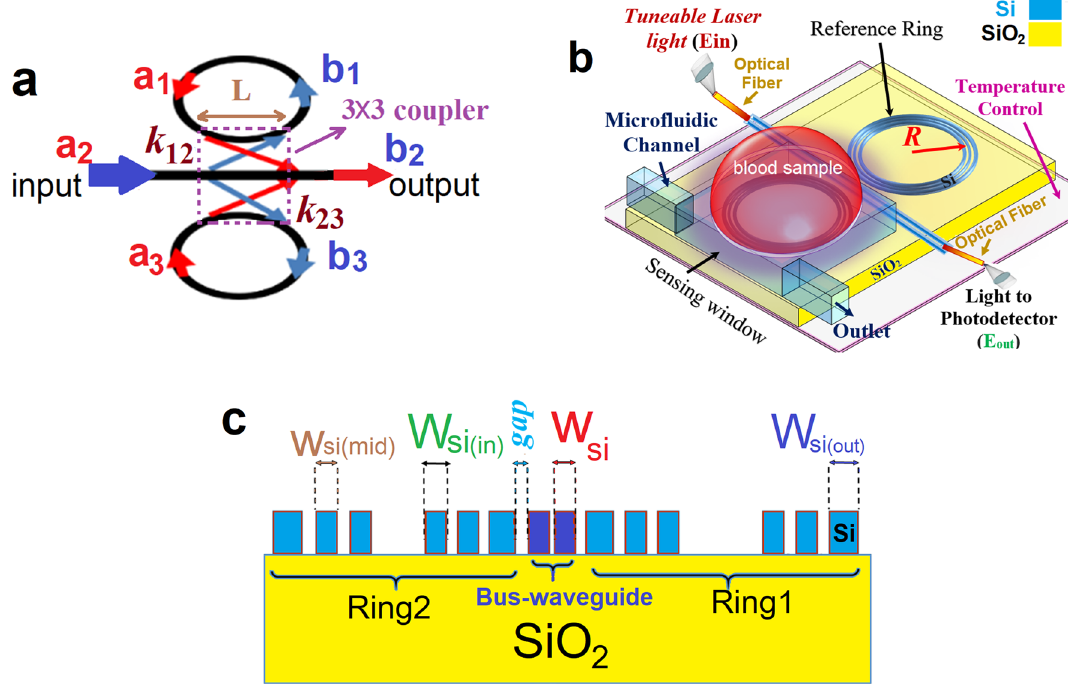
Figure 2. ( a ) The waveguide layout of an indirectly coupled cascaded ring resonator (ICCRR) comprised of a linearly distributed 3 × 3 coupler ( b ) a 3D structure of ICCRR sensor ( c ) the waveguide cross section of ICCRR